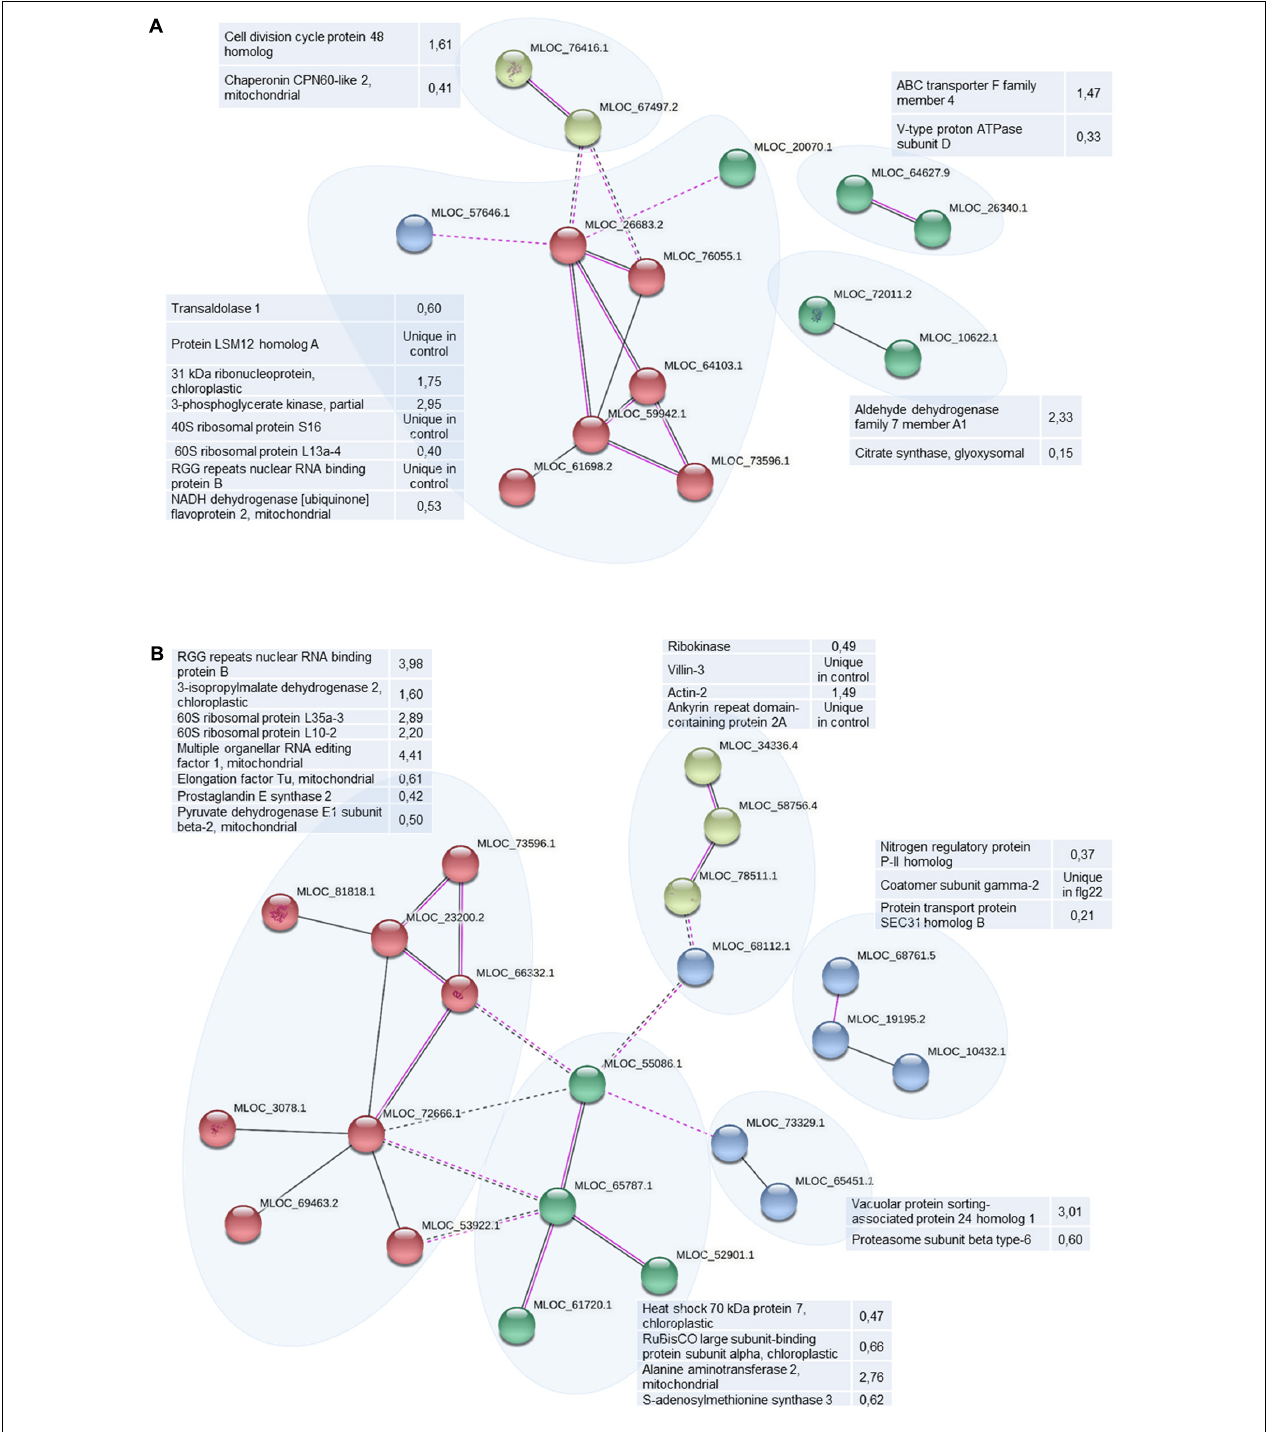
FIGURE 7 | Schematic presentation of protein interaction networks in differential proteomes of flg22-treated wild type [WT; (A) ] and HvMPK3 KO lines (B) as generated by STRING web-based application.